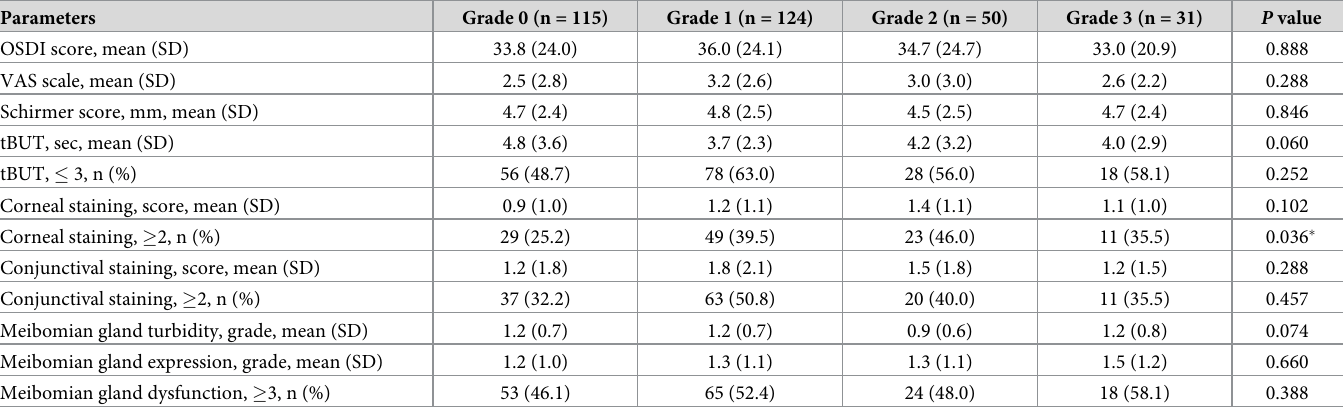
Table 4. Comparison of clinical signs and symptoms in semiquantitative results of MMP-9 point-of-care test.